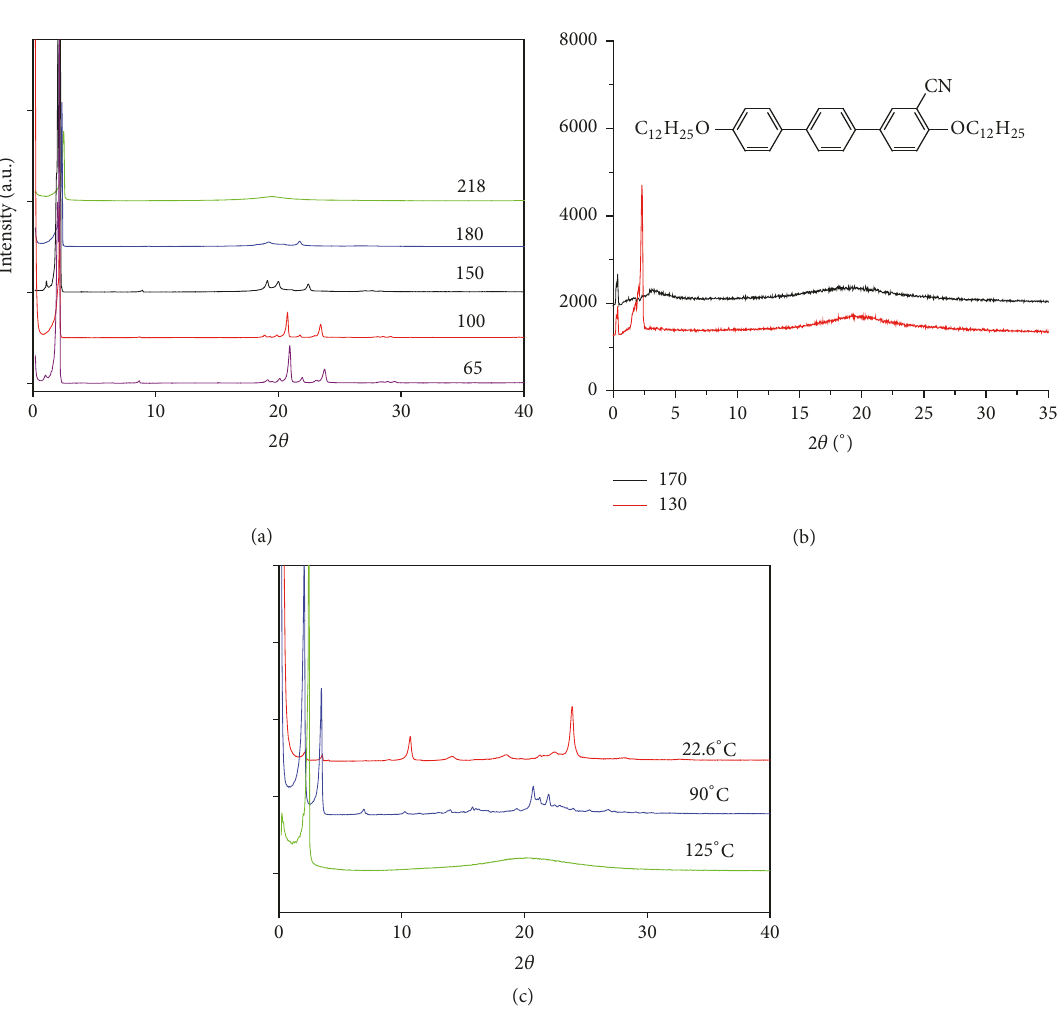
Figure 5: XRD patterns of the terphenyls (a) T12, (b) T12-CN, and (c) T12- 2CN.